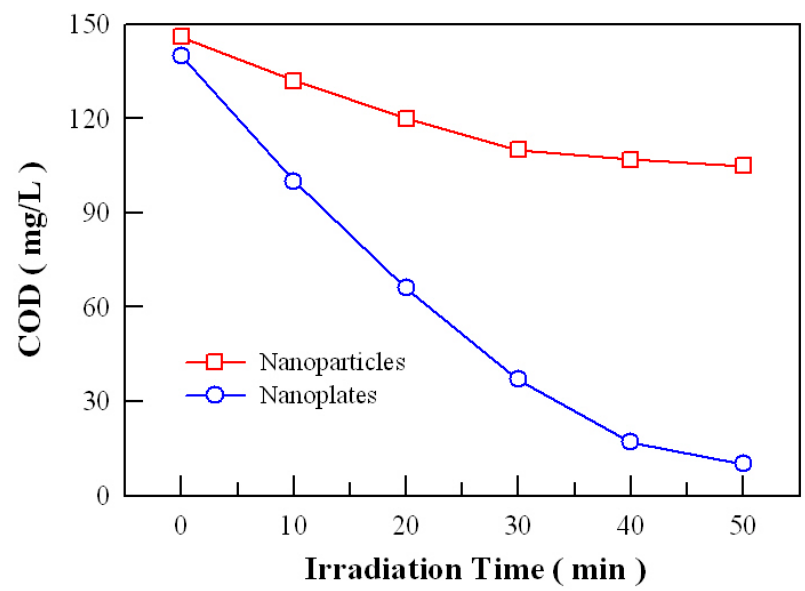
Figure 10. Chemical oxygen demand (COD) plots of methyl orange solution against the UV irradiation time in the presence of ZnWO 4 nanoplates ( a ) and in the presence of ZnWO 4 nanoparticles ( b ).